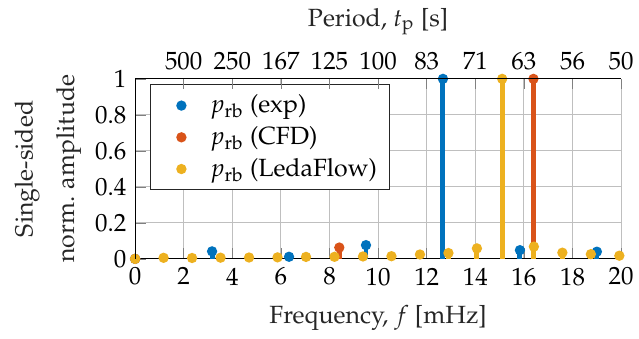
Figure 11. Comparison of Fast Fourier Transform (FFT) spectra of low-point pressures. The models are compared and evaluated in Table 4. Table 4. Comparison of 1D and 3D models.